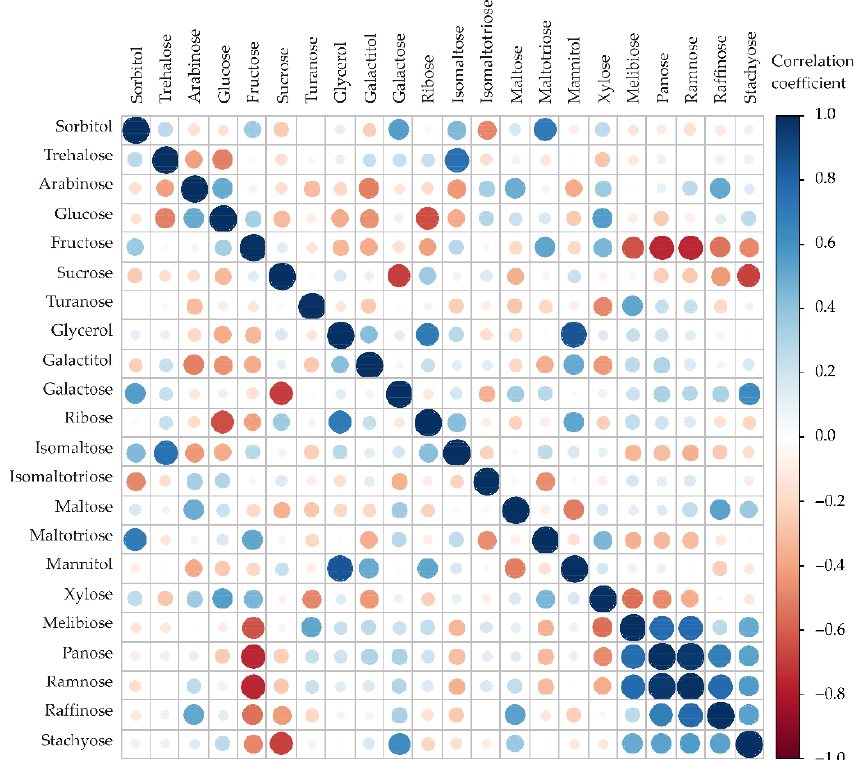
Figure A3. Color correlation graph between fruit acid contents in raspberry extract samples.